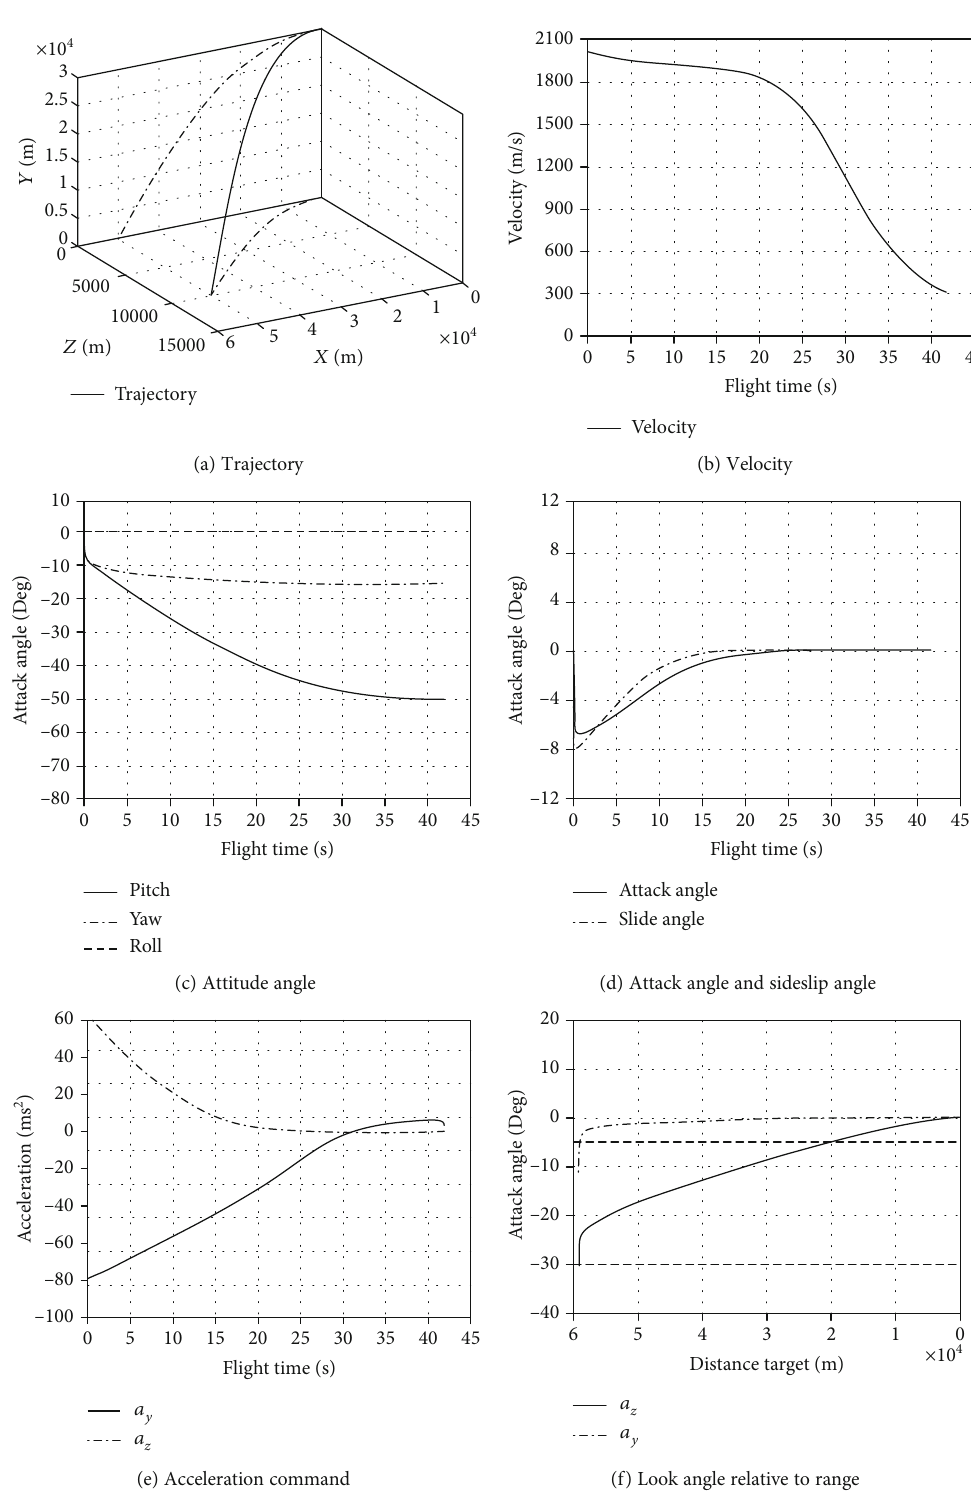
Figure 7: Simulation results without guidance